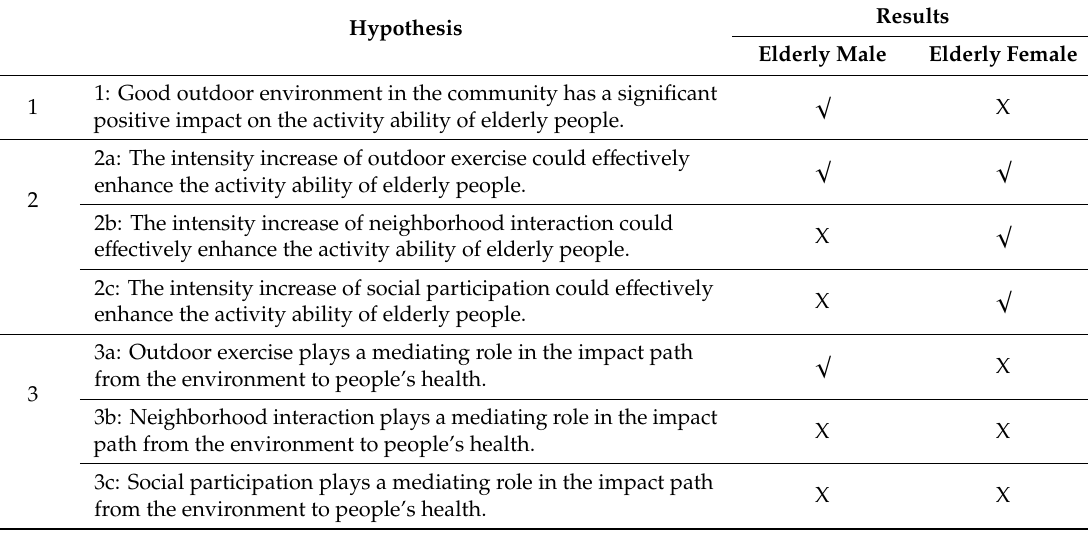
Table 5. The validation results of the